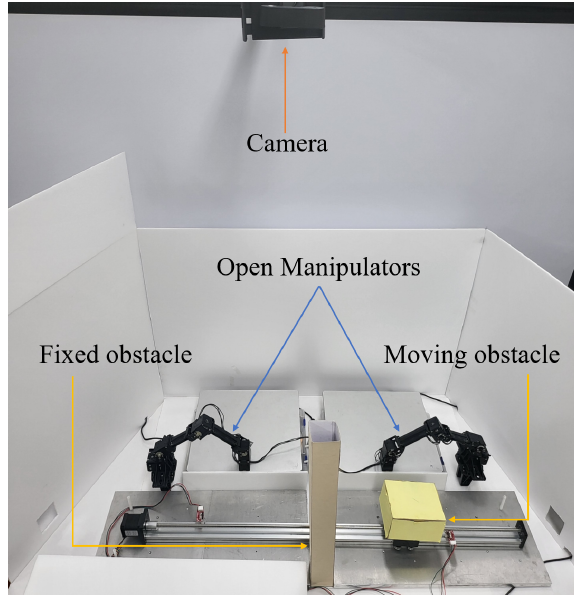
Figure 14. The experimental setup using two open manipulators and obstacles.